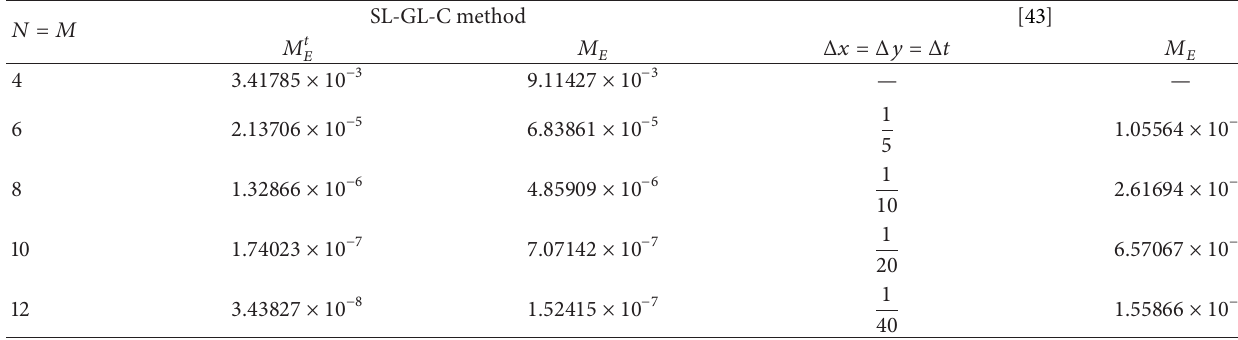
Table 1: Maximum absolute errors for problem (40) for 𝑇 = 1 .